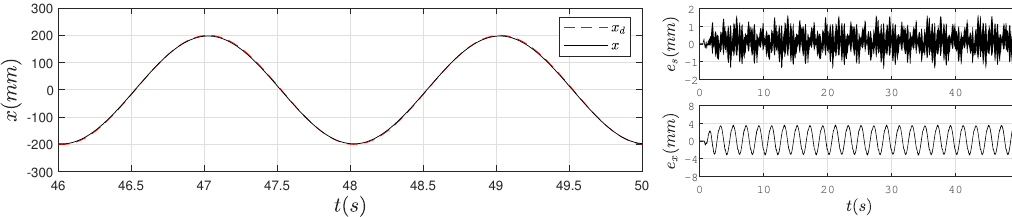
Figure 6. System output under the CCC controller and low-frequency excitation.